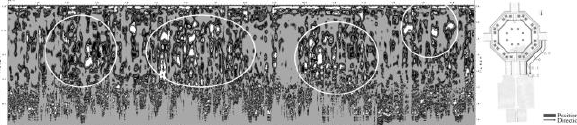
Figure. 5. Picture of southeast ground penetrating radar waveform.